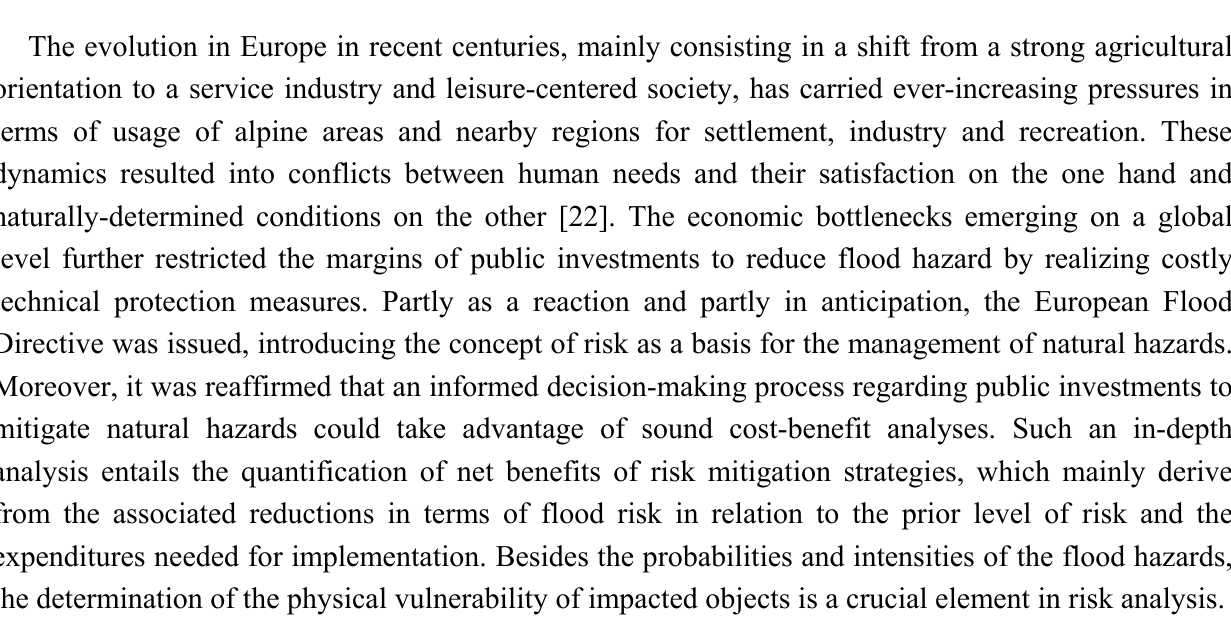
RM of a mitigation z